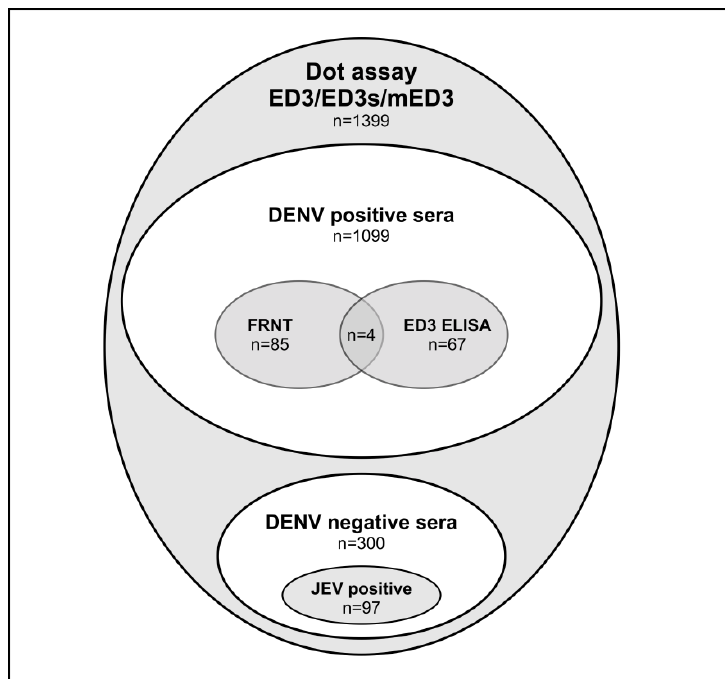
Figure 2. Sera used within this study. All 1399 sera were tested with the dot assay using recombinant ED3, ED3s and mED3 antigens of DENV-1-4. Samples included 1099 2 nd sera from confirmed DENV cases and 300 DENV-negative sera, the latter included 97 sera from JEV patients. Dot assay results of 67 sera were compared to ED3 ELISA results. Dot assay results of 85 sera were compared to foci reduction neutralization test (FRNT) performed to detect serotype-specific antibodies to one of the DENVs. ELISA, enzyme-linked immunosorbent